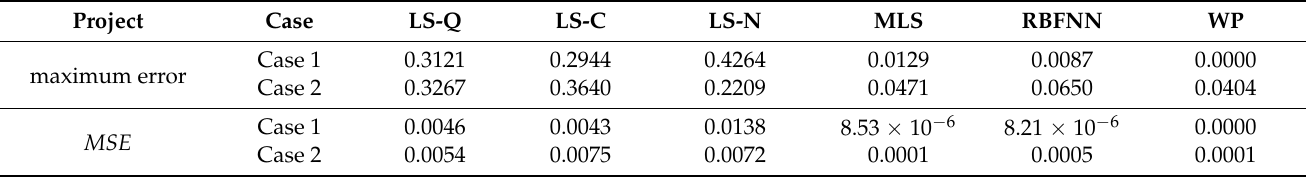
Table 6. Maximum error and MSE for TD1.